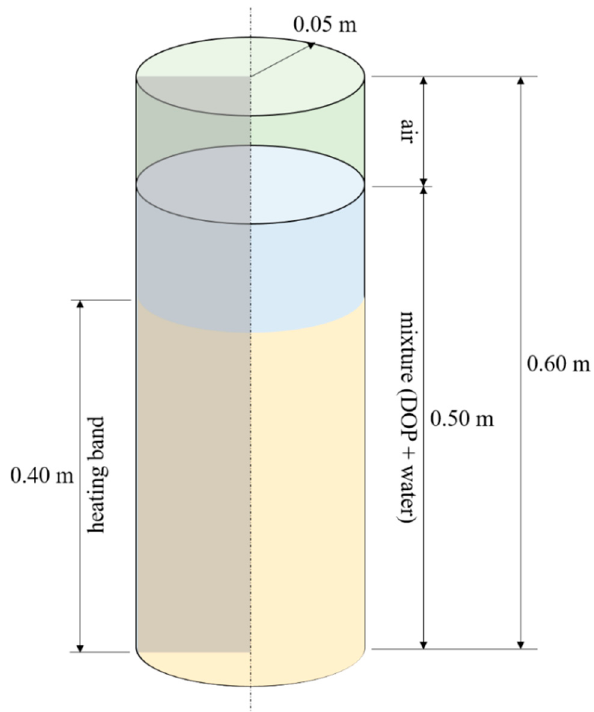
Figure 1. Geometry of the modelled reactor. The two-dimensional computational domain consists of a generic axisymmetric section. The yellow region represents the heating band.